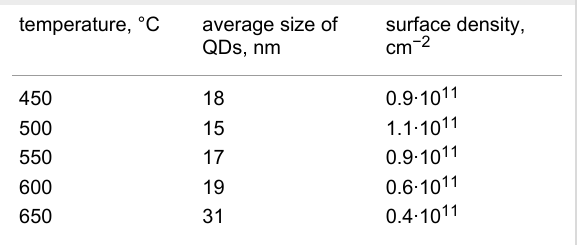
Table 1: Depending QDs average size and surface density on sub- strate